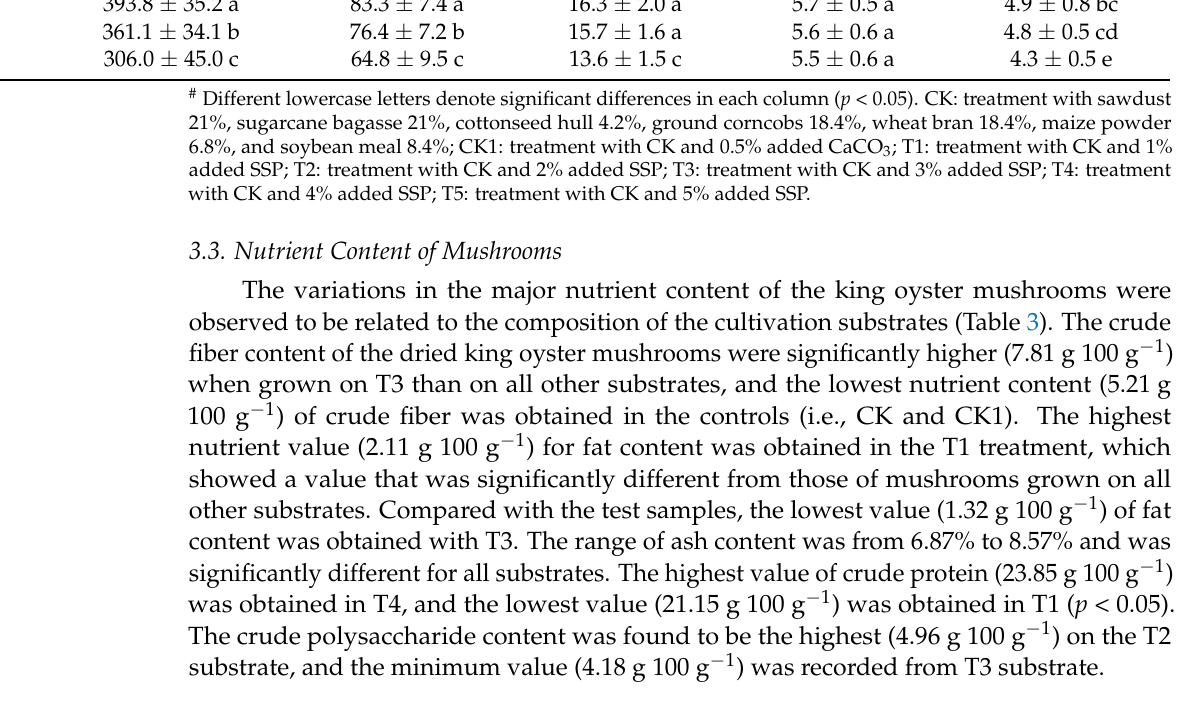
Table 3. Nutritional value of P. eryngii fruiting bodies cultivated on different substrates # * (g 100 g − 1